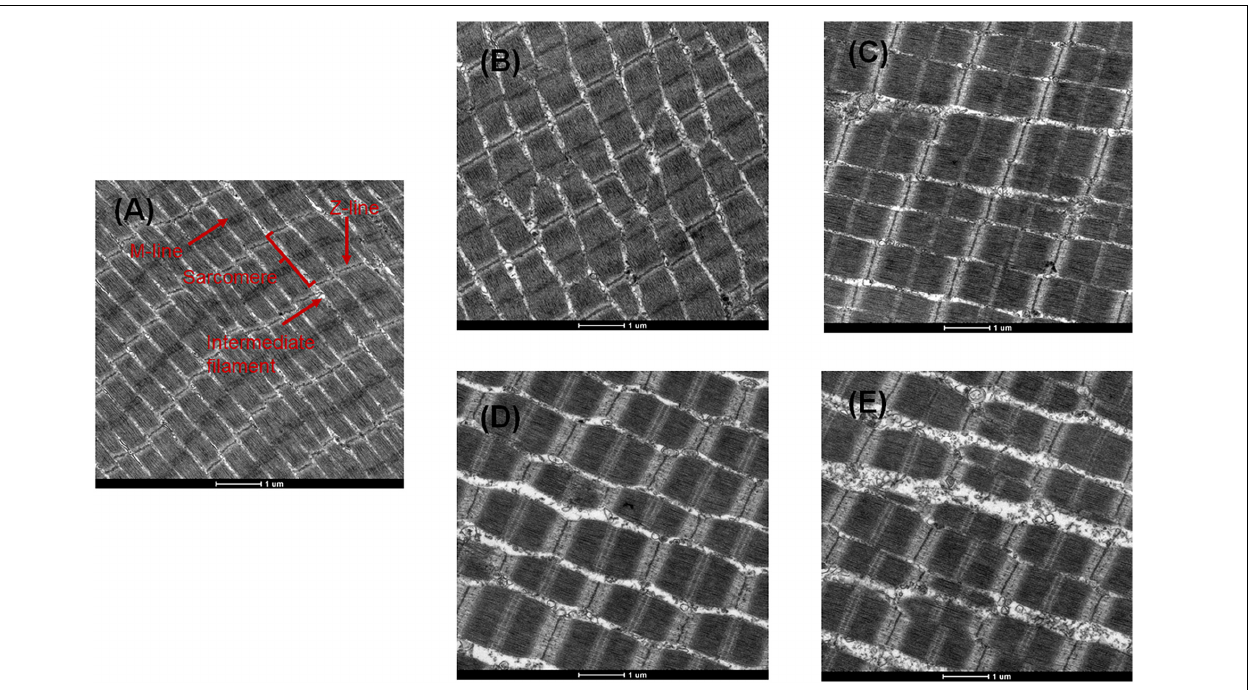
FIGURE 5 | Transmission electron microscopy (TEM) photographs of bigeye tuna muscle stored at 4 ◦ C for 0 day (A) , stored at 4 ◦ C in the control group for 6 days (B) , stored at 4 ◦ C in the A group for 6 days (C) , stored at 4 ◦ C in the S group for 6 days (D) , and stored at 4 ◦ C in the AS group for 6 days (E) .